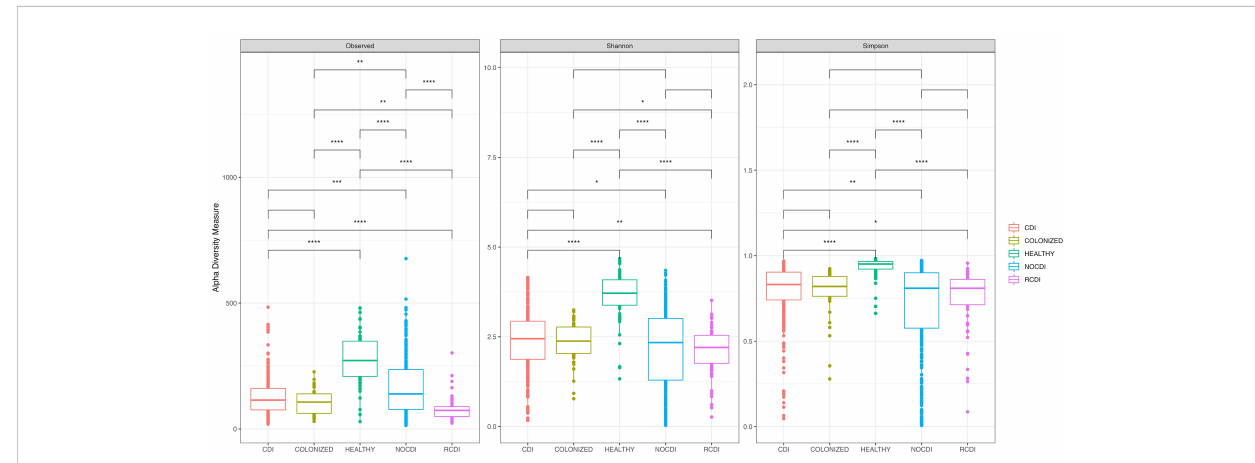
FIGURE 1 Box plot of Alpha diversity index (Shannon and Simpson) and Richness index (Observed) in all groups of patients. CDI, Clostridioides dif fi cile infection; NOCDI, Non C. dif fi cile diarrhoea; RCDI, recurrent CDI; Colonized, patients colonized with C. dif fi cile ; Healthy, Healthy subjects. *, p <= 0.05; **, p <= 0.01; ***, p <= 0.001; ****, p <=